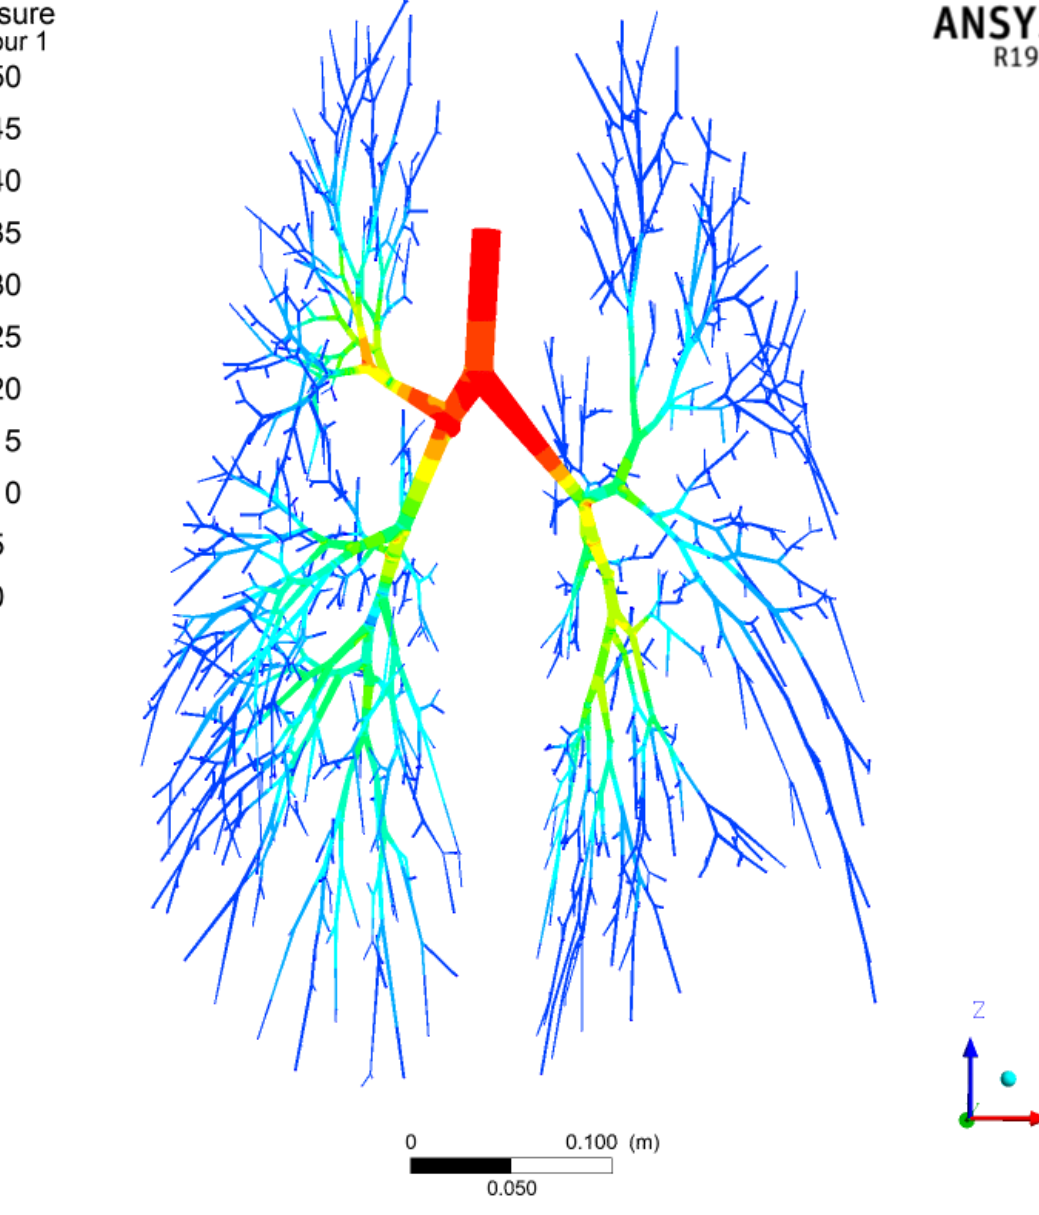
Figure 4. Pressure contours for CFD Test Case P-1 in Table 1.